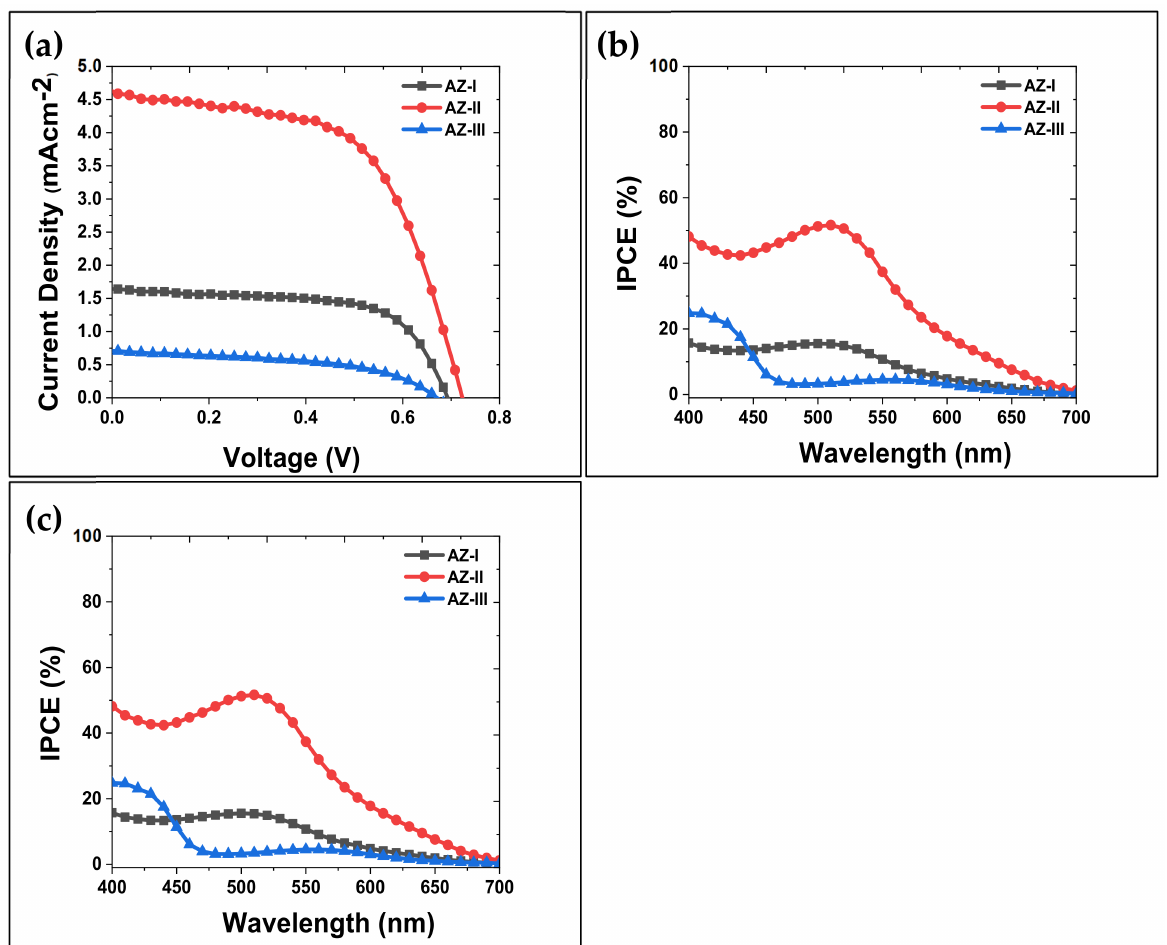
Figure 10. ( a ) J-V curves, ( b ) photoconversion efficiency (PCE) and ( c ) IPCE obtained using the fabricated